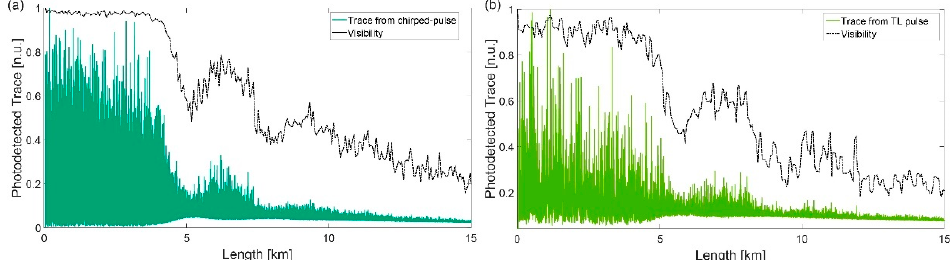
Figure 6. Comparison of the impact of MI in the optical traces for ( a ) for chirped pulse (using the experimental setup described in Section 2.2, with δυ p ≈ 400 MHz); ( b ) transform-limited (TL) pulse (@2016 The Optical Society [26]), using similar pulse intensity shapes (super-Gaussian, ≈ 100 ns FWHM) and pulse energies (165 nJ per pulse).